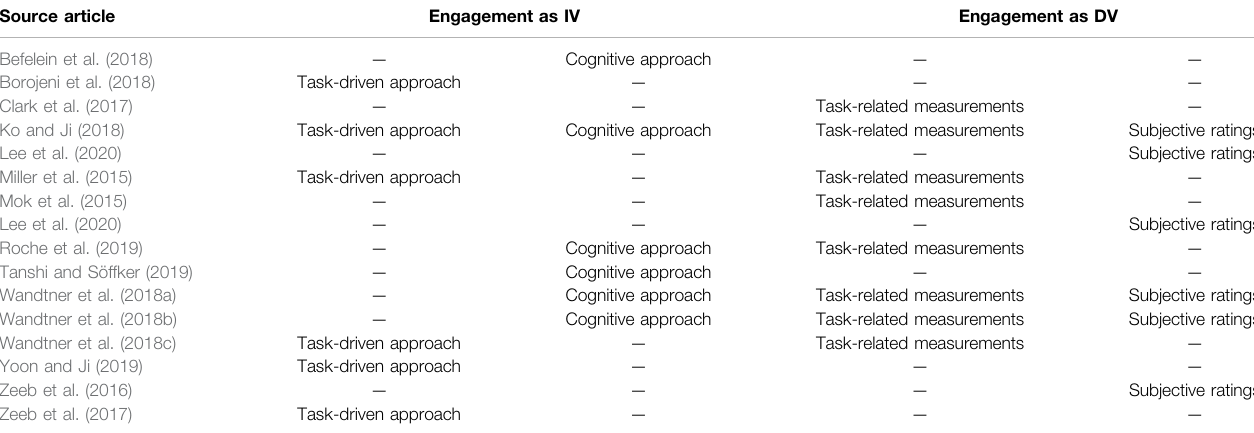
TABLE 1 | Overview of the repartition applied to the reviewed